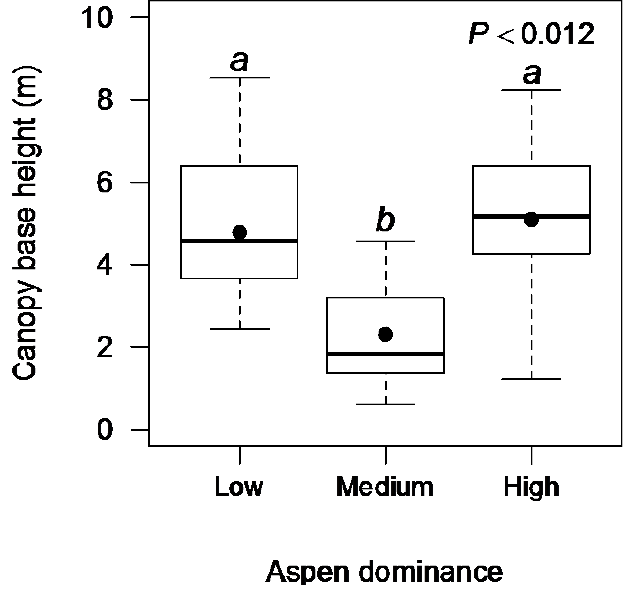
Figure 1. Canopy base height (m) for three aspen dominance classes. For each box plot the box represents the 1st and 3rd quartiles, whiskers denote 1.5 times the interquartile range, the heavy horizontal line inside the boxes indicates the median, filled circles indicate the mean, and unfilled circles indicate outliers. Different letters denote significant differences at the 95% level using a Tukey HSD test. Aspen dominance classes: low, 0%–33%, medium, 34%–66%, and high,